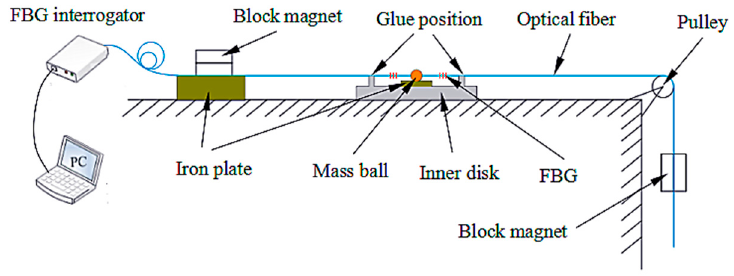
Figure 5. The curves of the sensor’s frequency and sensitivity change with mass of the mass ball.